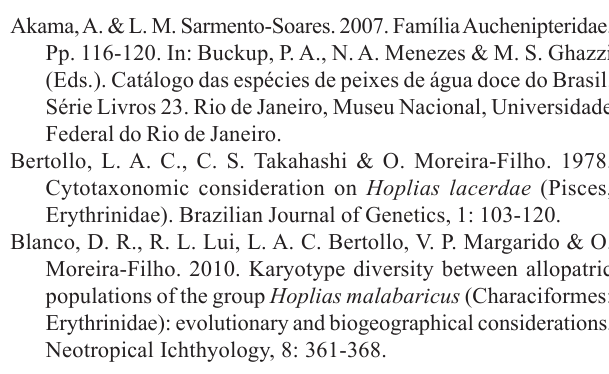
Fig. 3. Metacentric chromosomal pair 1 ( a ) stained with Giemsa, ( b ) C-banded and ( c ) hybridized with [TTAGGG] schematic illustration in (d) represents the possible fusion rearrangement which originated this